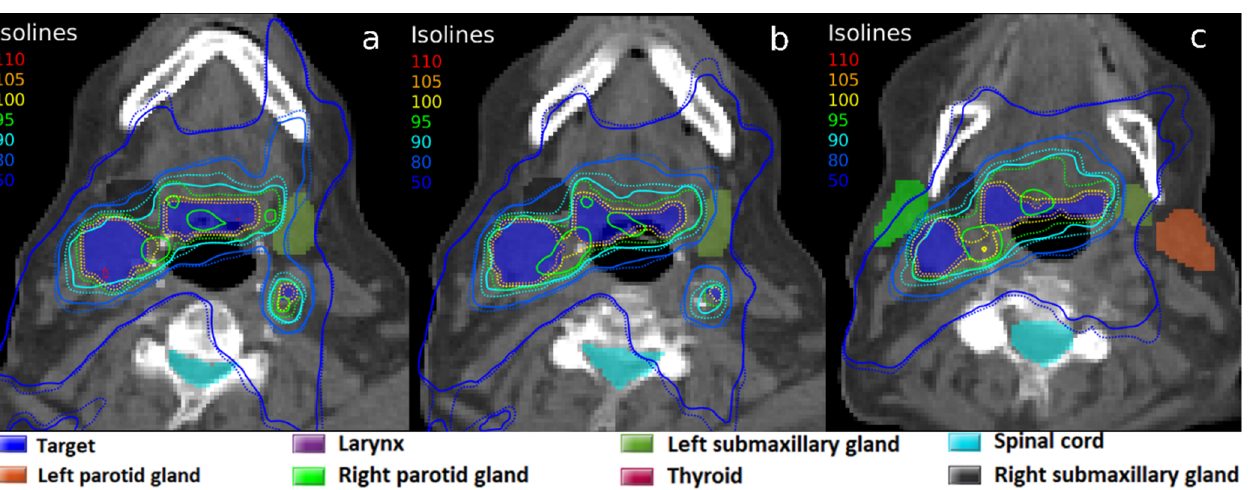
Figure 4. Isodoses in three axial CT slices ( a – c ) corresponding to the same radiotherapy treatment planning with the MV-CBCT beam: dose calculation without AuNP (solid line), and with a simulated 22.3 mg Au·g − 1 tissue concentration of AuNP in the target volume (dotted line). 100% isodoses represent the clinical prescribed dose of 70 Gy.